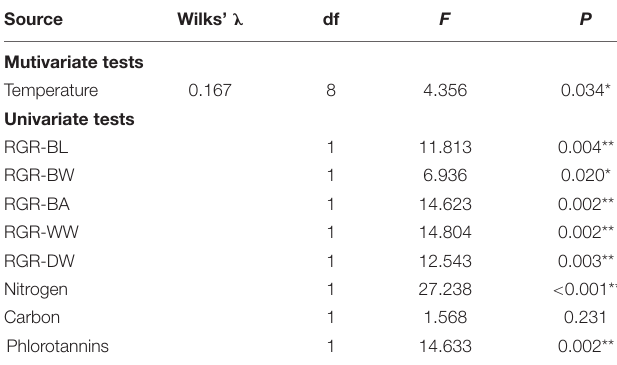
TABLE 4 | Results of MANOVA on the effect of temperature on the RGRs and chemical compositions of E. bicyclis juvenile